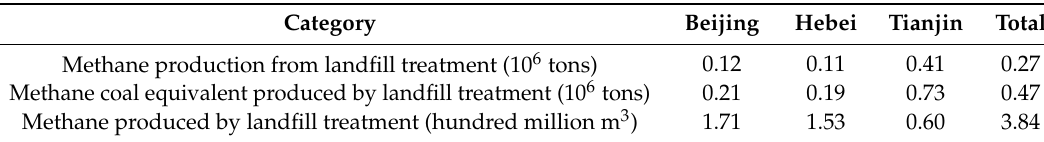
Table 12. The biogas production and coal equivalent of MSW.